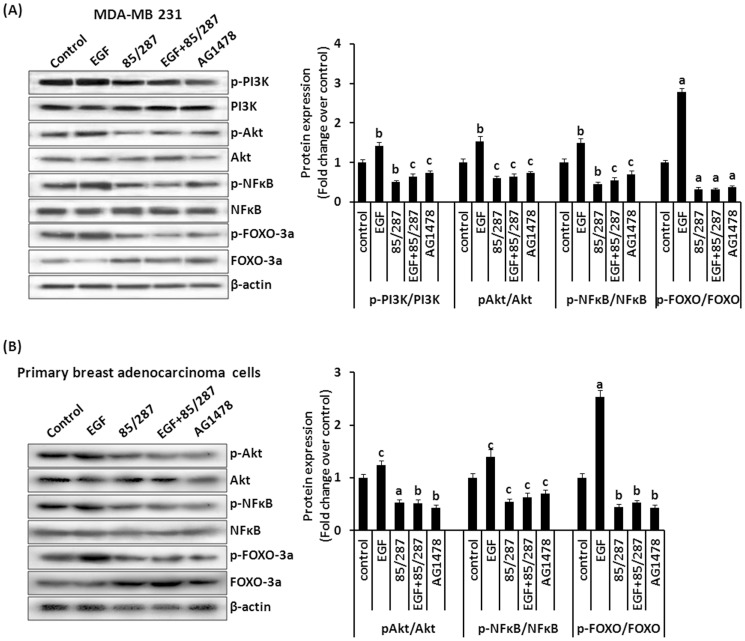
CDRI-85/287 modulates PI-3-K/Akt, NF-κB and FOXO-3a pathway.Analysis of PI-3-K, Akt, NF-kB and FOXO phosphorylation in (A) MDA-MB 231 and (B) primary breast adenocarcinoma cells. Cells were treated with the indicated concentrations of compound for 24h and 30 µg whole cell lysate in each lane was probed for the expression of different proteins using specific antibodies. β-actin was used as a control to correct for loading. Representative blots are shown in left panel and densitometric analysis of bands is shown in right panel. Results are expressed as mean ± SEM, n = 3. p values are a-p<0.001, b<0.01, c-p<0.05 and d-p>0.05 vs. control.